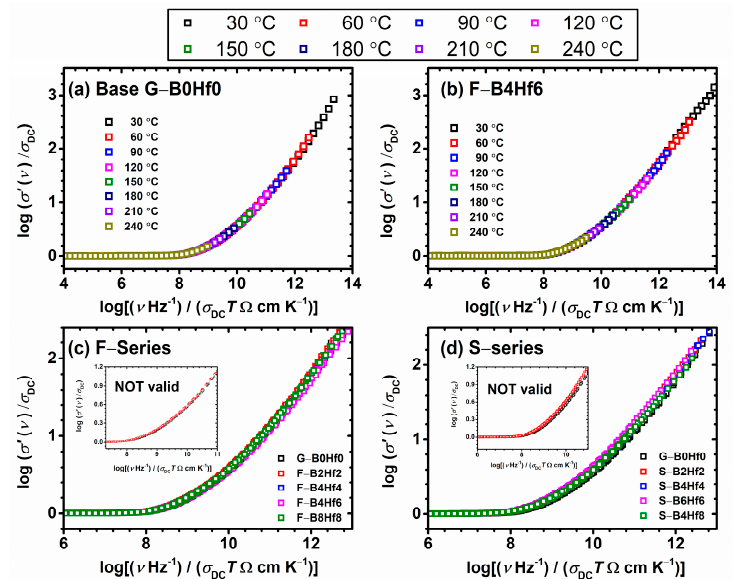
Figure 5. Conductivity spectra scaled according to Summerfield scaling procedure for ( a ) S − and ( b ) F − glass series and ( c , d ) construction of super-master curve of the conductivity isotherms using the Summerfield scaling procedure for studied F − and S − glass series. Inset ( c , d ): individual master-curves shifted along the x -axis to overlap with the reference master-curve of base G − B0Hf0 glass.